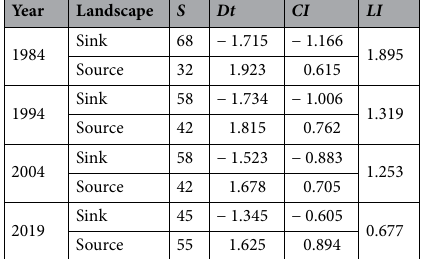
Table 6. Variations in LST of the source and sink with their landscape index over